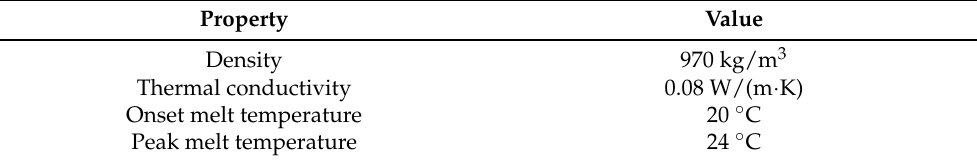
Figure 1. DSC output curve for heating of PCM sample (Data provided by Scanscap [44]). Table 2. Thermal properties of the PCM